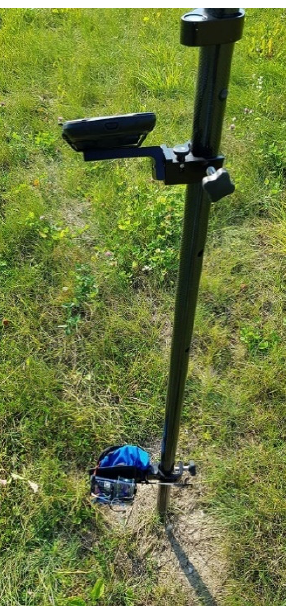
Figure 6. Device ready for measurements right above the ground.